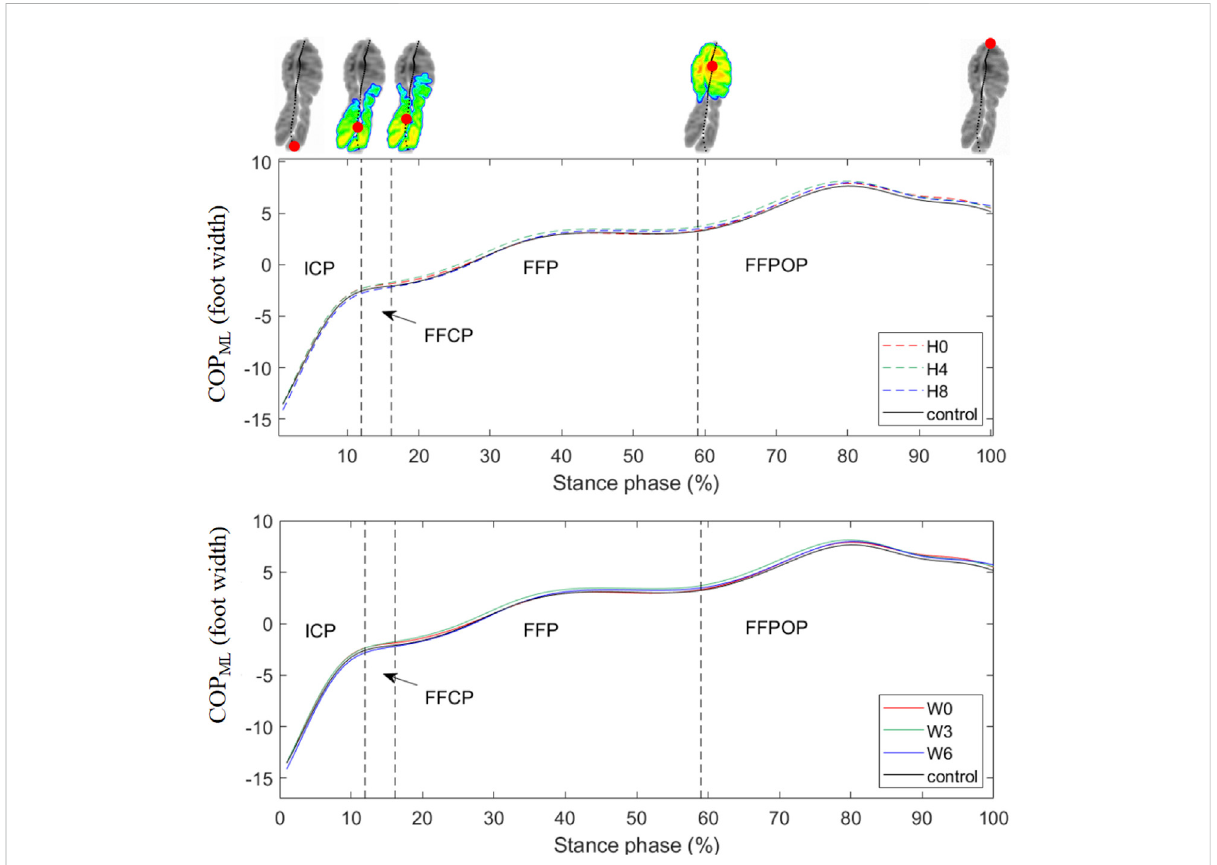
FIGURE 3 Mean curves of the COP ML coordinates during running. Medial displacements of the COP ML were expressed as positive values. H0, H4, and H8 represented the mean data of arch supports of three different heights; W0, W3, and W6 represented the mean data of arch supports of three differentwidths.Foursubphasesareindicatedwithverticaldashlinesonthe x -axis.ICP,initialcontactphase;FFCP,forefootcontactphase;FFP,foot fl at phase; FFPOP, forefoot push off phase; IFC, initial foot contact; IMC, initial metatarsal contact; FFC, forefoot contact; HO, heel-off; TO,